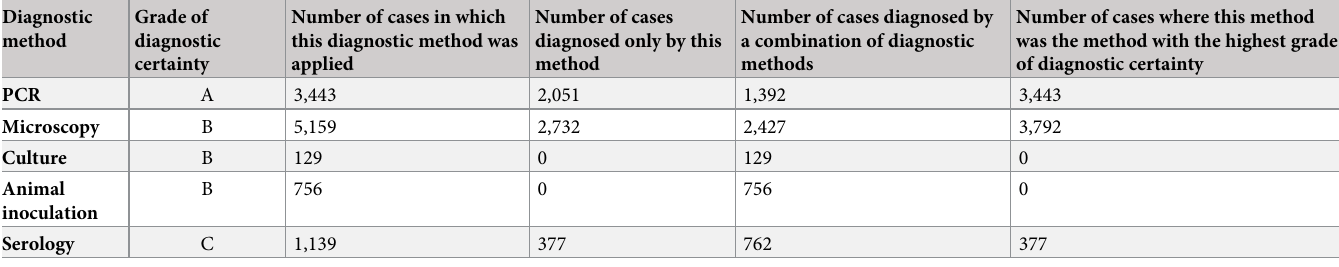
Table 6. Diagnostic methods used to diagnose TBRF in 7,612 cases (n = 240 studies). Diagnostic method